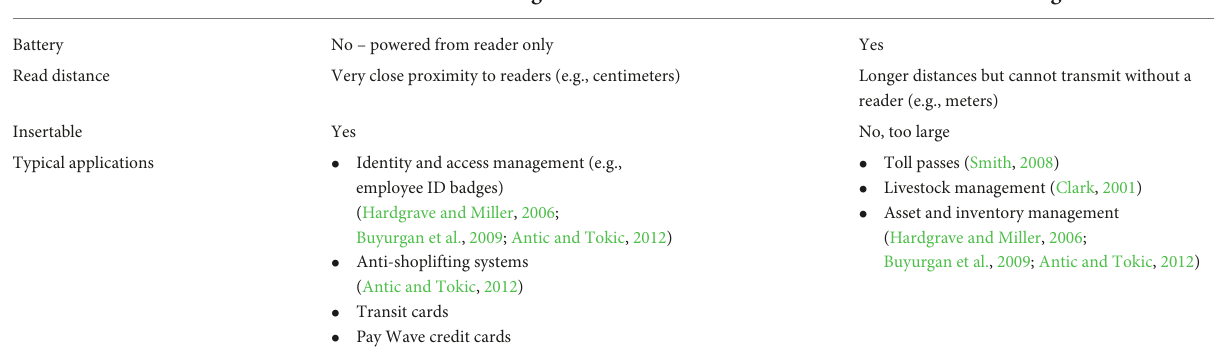
TABLE 1 Passive and active NFC and RFID tag comparison and typical